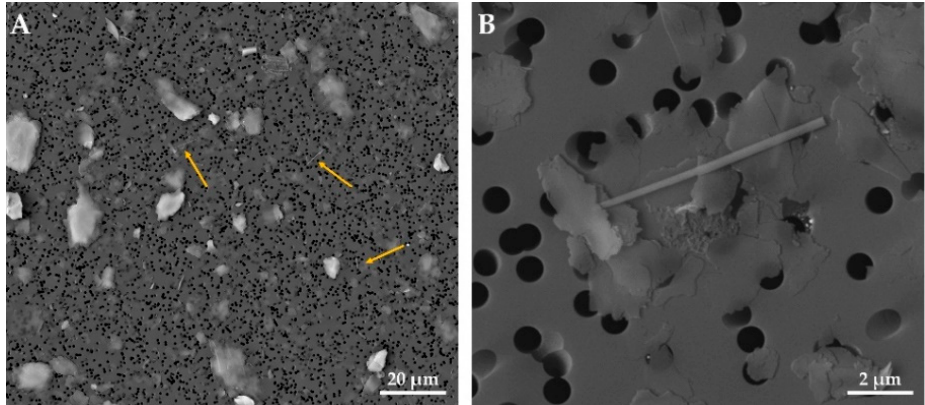
Figure 4. Acicular rutile from massive shale sample. Overview of the reading field at 2000× ( A ) and detail of rutile fiber at 20,000× ( B ). Scale bar in microphotographs; High Vacuum: 20 kV; Detector: Back Scattered Electrons.